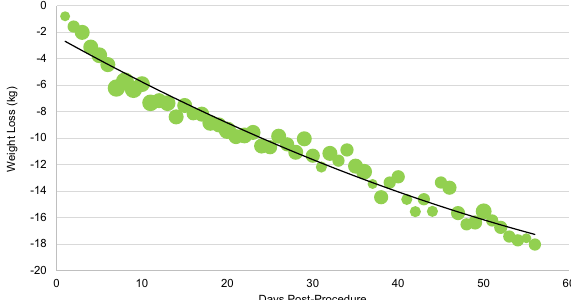
Fig. 4 Average cumulative weight change from baseline for patients who underwent bariatric surgery ( n = 29). Bubble size corresponds to number of patients for whom data were synced. Procedure occurred on day 0. Data obtained via Withings Body Scale.